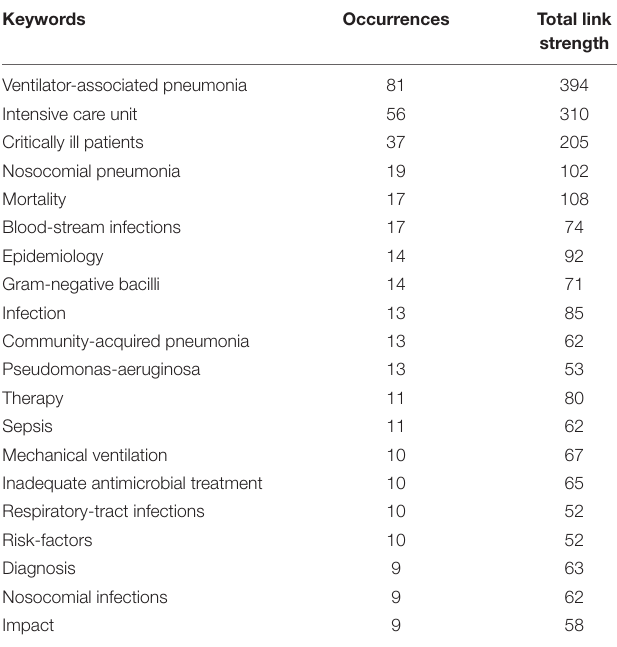
TABLE 4 | Top 20 terms with most frequent occurrence in the titles or